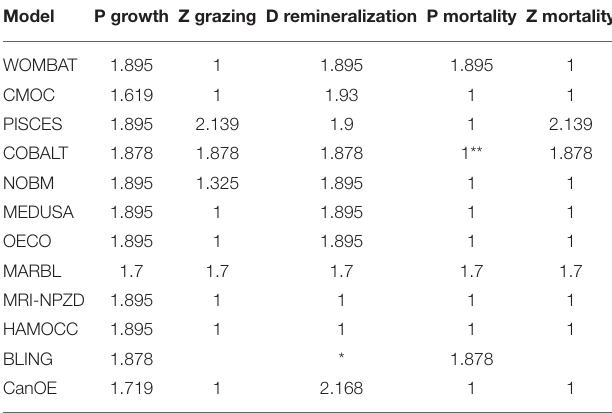
TABLE 6 | Per unit biomass grazing functional responses of predator j on prey i , with other available prey groups k .